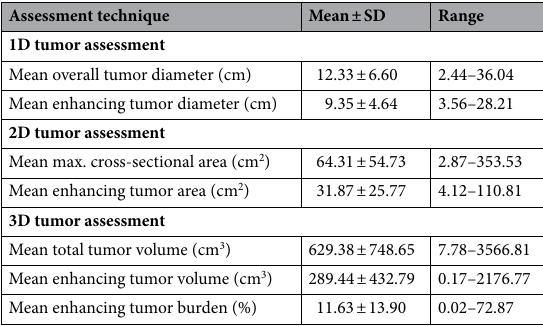
Table 2.. 1D, 2D, and 3D tumor burden assessment.